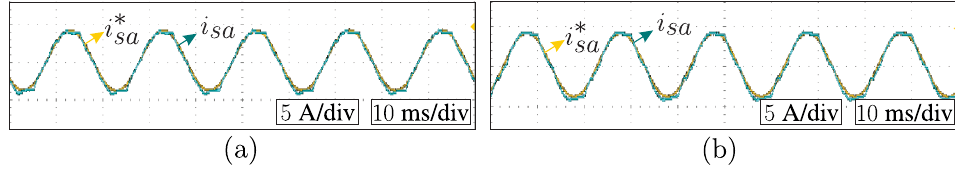
Figure 13. Gain adjustment validation, Λ . ( a ) Λ = 0.0001. ( b ) Λ = 2000.